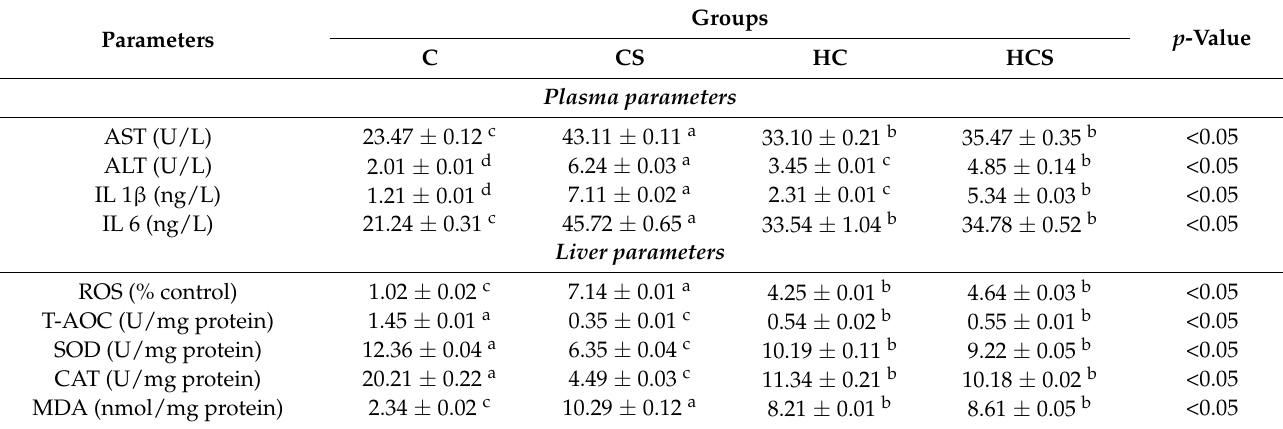
Table 4. Plasma and liver parameters of blunt snout bream subjected to different